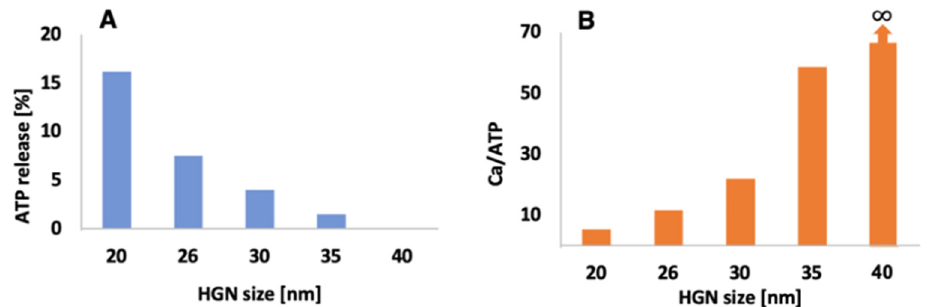
Figure 19. ( A ) Liposomes containing calcium were tethered to 10 nm HGN and mixed with equal volumes of liposomes with 20 nm, 26 nm, 30 nm, 35 nm, and 40 nm HGN encapsulating ATP. All HGN had an identical λ max of 800 nm. The mixed liposomes were triggered with single pulses of 800 nm NIR light at a constant fluence of 42 mJ/cm 2 . This fluence was sufficient to induce ~90% calcium release. However, the fraction of ATP released from otherwise identical liposomes decreased with increasing HGN size, dropping to 0 for 40 nm HGN. ( B ) This gives a release ratio of calcium to ATP that could be varied from 5:1 for the 20 nm HGN to infinity for the 40 nm HGN. Adapted from [48], published by Nature, 2020. By controlling the liposome and HGN properties, any ratio of liposome contents can be released from a mixture of liposomes simultaneously with a single laser pulse. Adapted from [48], published by Nature, 2020.